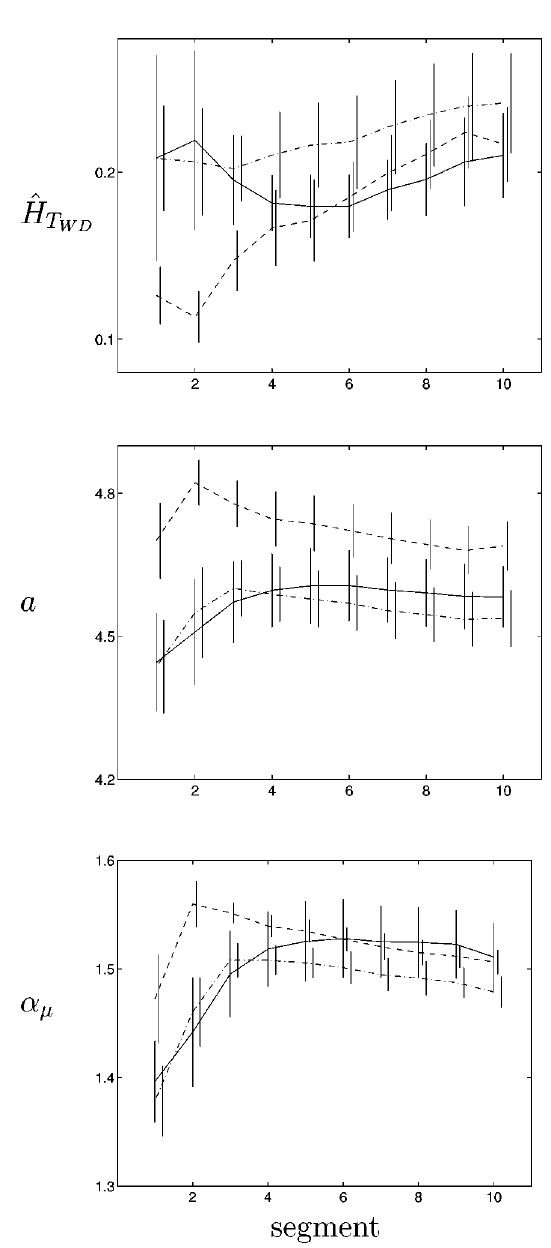
Fig. 7. Average estimated Hurst parameter, ^ H T , (top), regression WD coefficient a (middel) and scalar lacunarity parameter, (cid:11) (cid:22) , (bottom) for samples from the normal+regenerating (- -), noduli (- (cid:1) ) and tu- mour (—) classes, as obtained from the 1D polygonization method, are plotted versus segment. The standard deviation of each feature for each class and segment is indicated. This is based on the mean feature values obtained for each sample in each